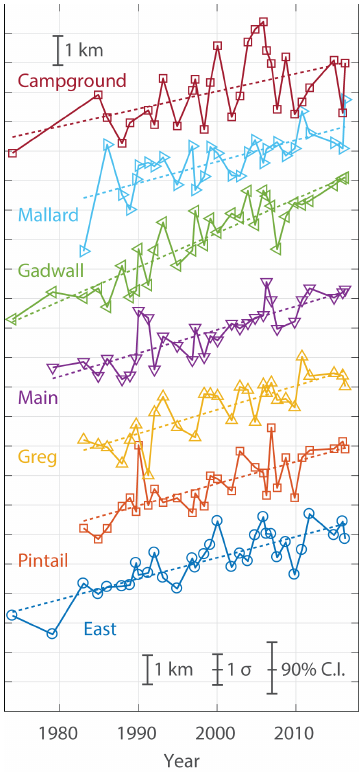
Figure 8. Growth of individual channels over time. Each series is plotted at the same scale (horizontal lines 1km, vertical lines 10 years), but shifted vertically for clarity. The uncertainty asso- ciated with (cid:49)l measured at Wax Lake Delta (Fig. 6a) is shown with a standard deviation ( σ ) and 90% confidence interval (CI) at the bottom. The primary distributary channels are shown from west to east: Campground Pass (maroon squares), Mallard Pass (turquoise right-pointing triangles), Gadwall Pass (green left-pointing trian- gles), Main Pass (purple down-pointing triangles), Greg Pass (yel- low up-pointing triangles), Pintail Pass (red squares), and East Pass (blue circles). Dashed lines show linear regressions of each dataset.